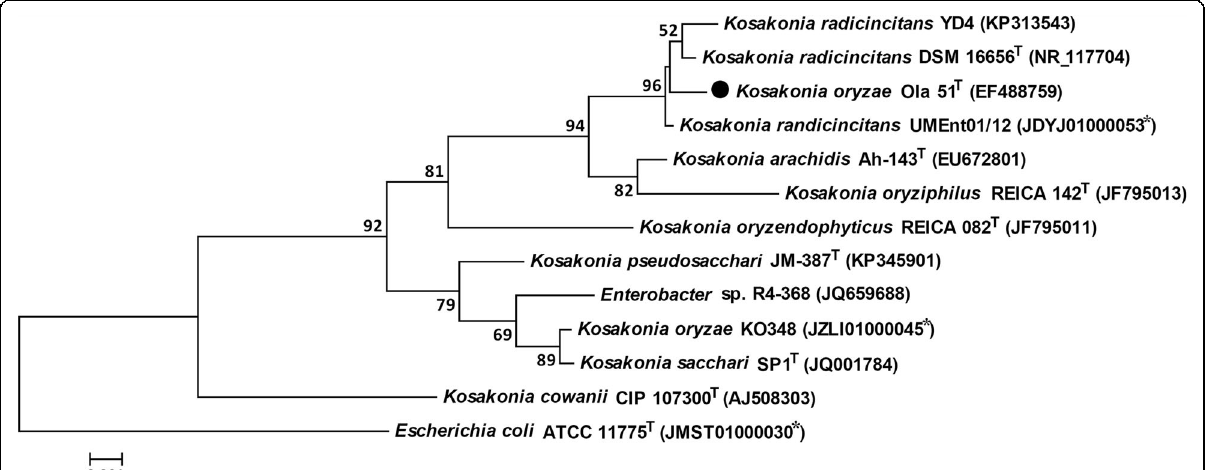
Fig. 2 Phylogenetic tree based on the 16S rRNA gene sequences showing the phylogenetic position of the Kosakonia oryzae type strain Ola 51 T ( ● ) and other strains belonging to the genus Kosakonia . The sequences were aligned using the SINA (SILVA Incremental Aligner) Alignment Service [42] and were constructed to the phylogenetic tree with the neighbor-joining algorithm and the Kimura 2-parameter model integrated in the MEGA 5.2 program [43]. Bootstrap values (>50%) of 1,000 tests are shown at the nodes. The tree was rooted on the outgroup Escherichia coli ATCC 11775 T . The GenBank accession numbers of the sequences are indicated in brackets; * indicates the accession number of a contig of the whole genome sequence. The scale bar indicates 0.1% substitutions per